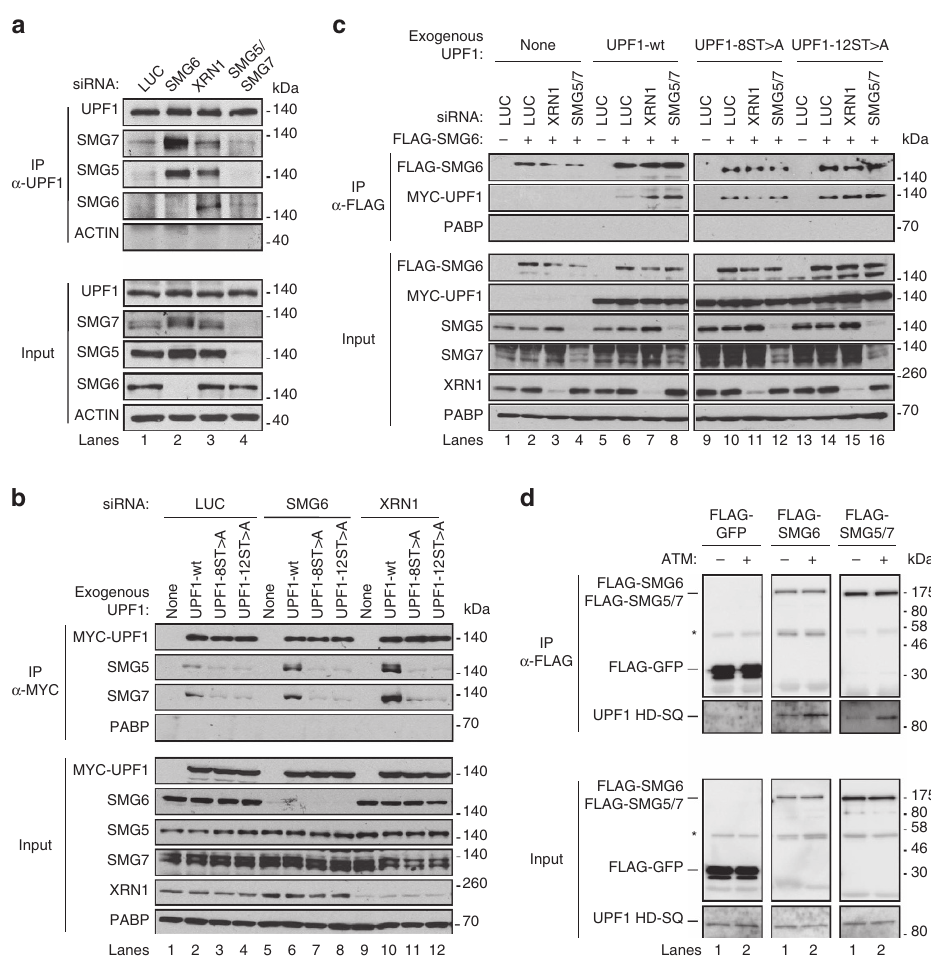
Figure 5 | Phosphorylation-dependent enhanced association of UPF1 with SMG5-7 when downstream NMD factors are limiting. ( a ) Western blots showing protein levels in UPF1-immunoprecipitated (IP) or total (1% of Input) fractions from HeLa tet-off cells transfected with the indicated siRNAs. ( b , c ) Same as panel a but monitoring IPs and input samples for exogenously expressed Myc-tagged wild-type and mutant UPF1 proteins (8ST 4 A ¼ [S/T] 7,8,9,10,11,17,18,19A; 12ST 4 A ¼ [S/T]1,2,7,8,9,10,11,15,16,17,18,19A). FLAG-tagged SMG6 was co-transfected with Myc-UPF1 in c . ( d ) Western blots for in vitro pull-downs of bacterially expressed UPF1 HD-SQ with FLAG-tagged GFP, SMG5/7 or SMG6 immuno-isolated from human cells. UPF1 HD-SQ was treated with or without ATM kinase prior to pull-down. Input samples are shown below. *Antibody heavy